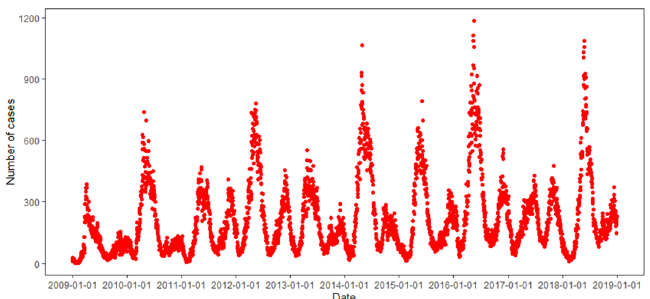
Figure 1. The temporal distribution of daily reported HFMD incidence from 2009 to 2018 in Hubei Province,